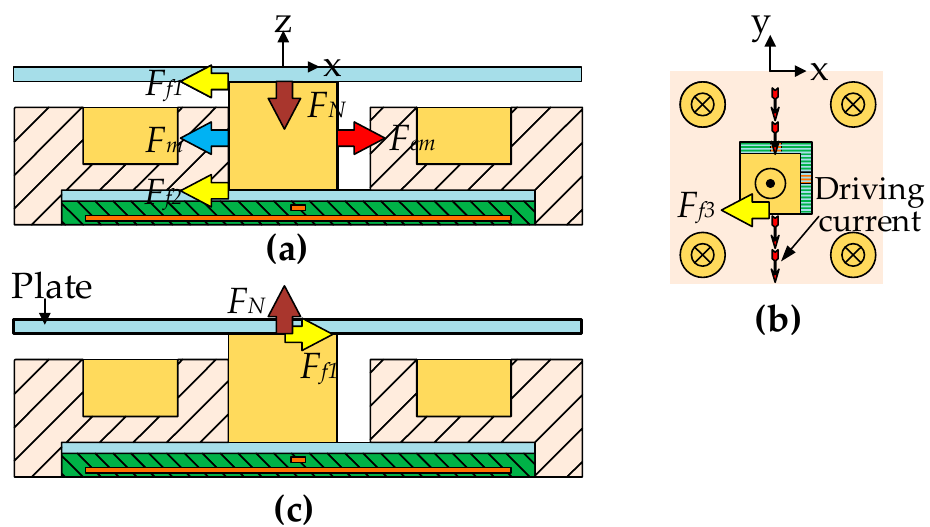
Figure 3. Forces distribution diagram of each actuator. ( a ) Forces exerted on the MPM—Front view. ( b ) Forces exerted on the MPM—Top view. ( c ) Forces exerted on the conveyed plate. According to Newton’s second law, the acceleration of each MPM ( α 1 ) can be calculated by Equation (1), which is an important parameter for determining the displacement of the plate. If α 1 is not zero, it indicates a non-zero value of the friction force ( F f 1 ), the plate then begins to move. The acceleration ( α 2 ) of the conveyed plate can be calculated by Equation (2). The theory displacement of the conveyed plate can be achieved through quadratic integral to the acceleration ( α 2